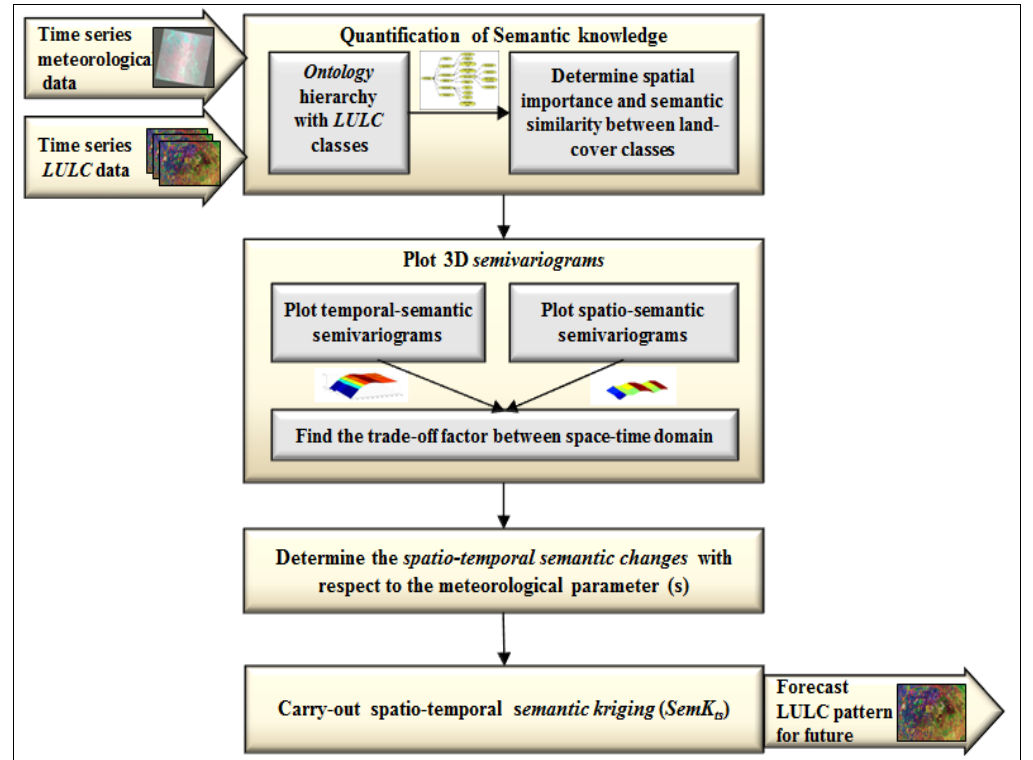
Figure 3. Rev-SemK ts